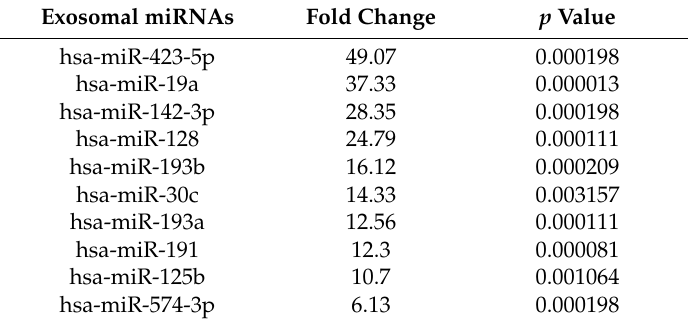
Table 2. Top 10 exosomal microRNAs differentially expressed between late-onset acute GVHD and non-GVHD.